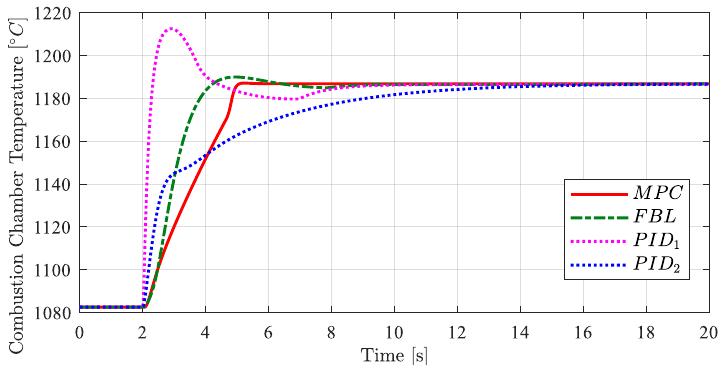
Figure 7. Combustion chamber temperature (CCT) time profile.